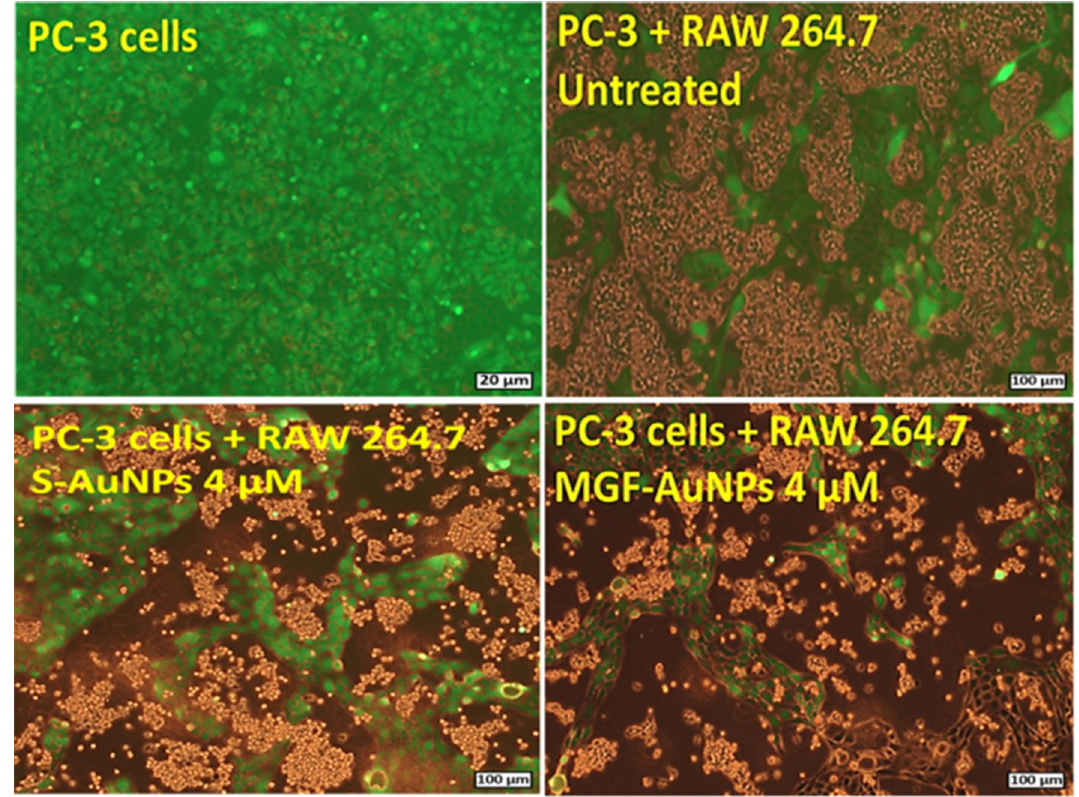
Figure 9. MGF-AuNPs-treated macrophages inhibited the proliferation of prostate tumor cells. Raw 264.7 macrophages were pre-treated with MGF-AuNPs for 18 h. Separately, PC-3 cells were labelled with CFSE to assess their proliferation. The macrophages were then co-cultured with PC-3 cells for 72 h. The images were obtained by fluorescent